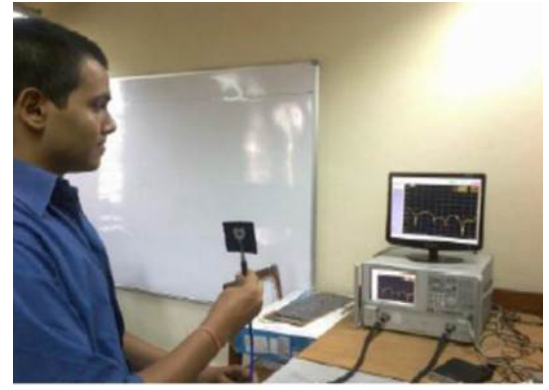
Figure 8: Proposed antenna while measuring results on vector net- work analyser in IIT Kanpur lab.